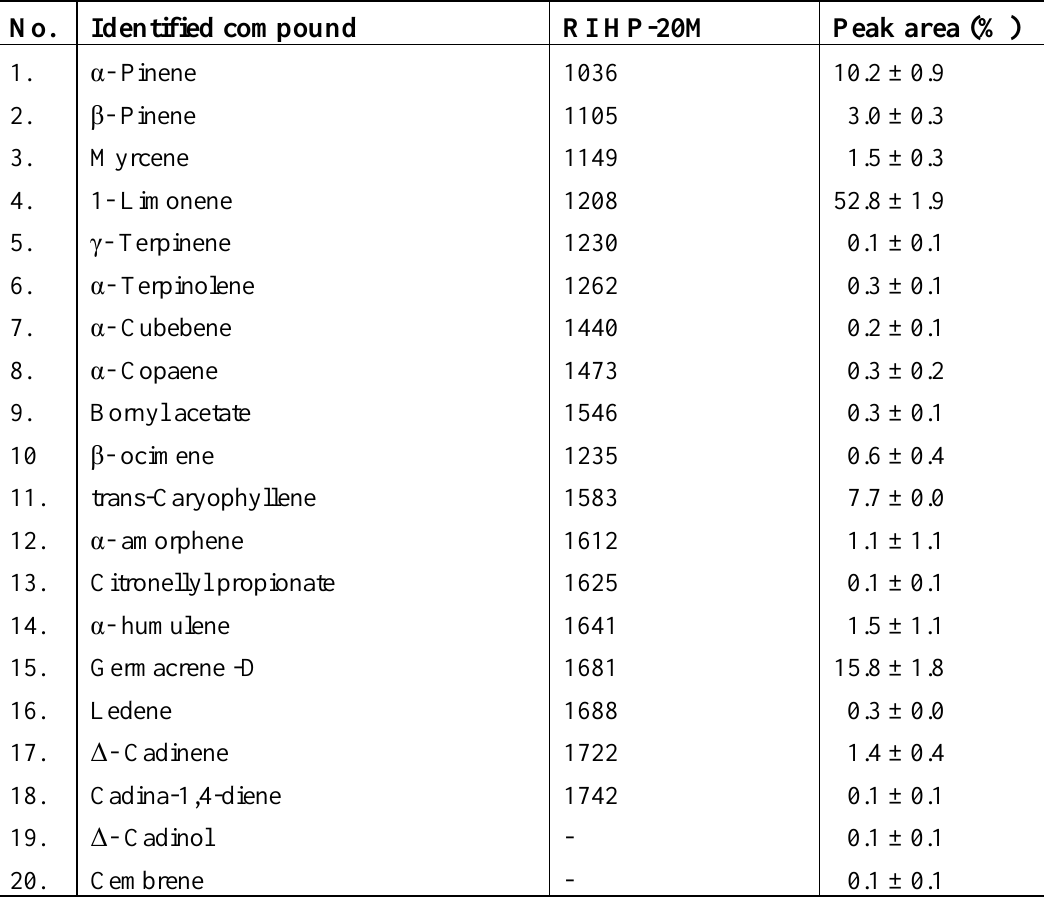
Table 2. Chemical composition of the essential oil isolated from Bosnian pine.